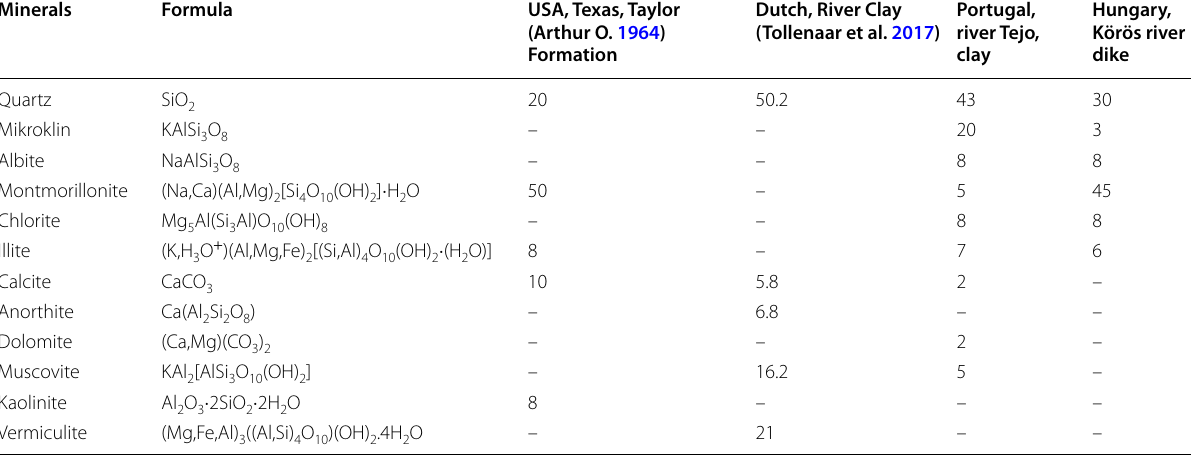
Table 1 Mineralogical composition of soils with shrink-swell behaviour Minerals